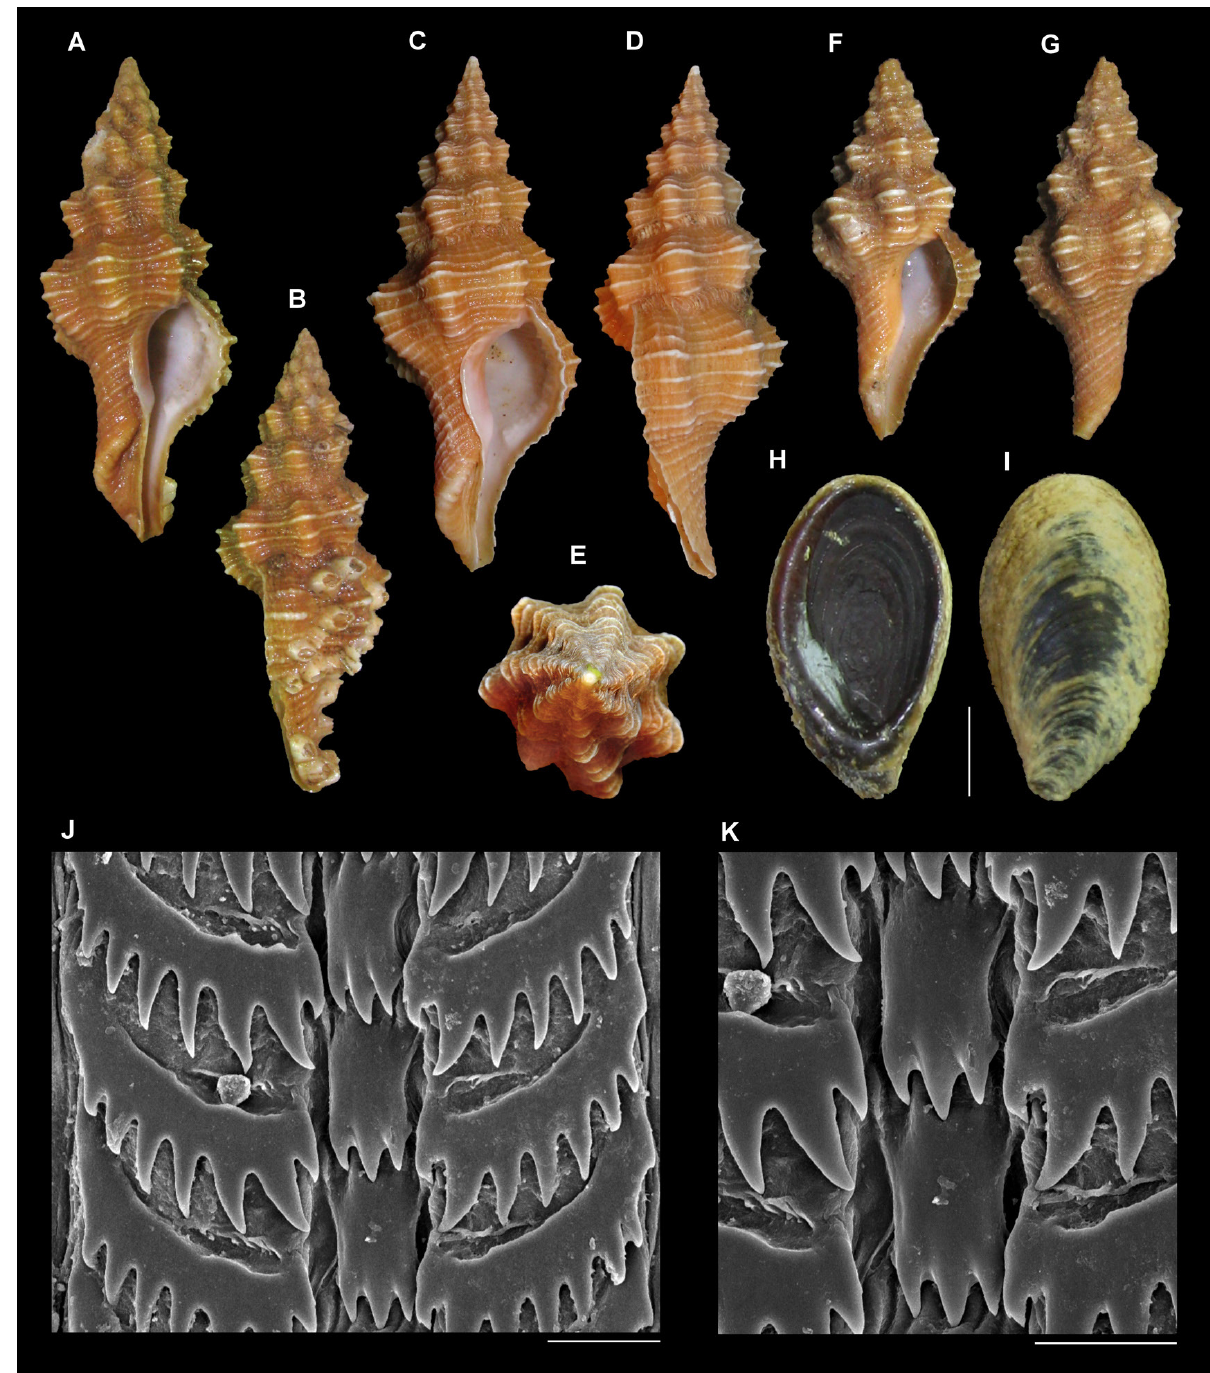
Fig. 6. – Hemipolygona beckyae . A-B, 55.4 mm (MZSP 69764); C-E, 52.4 mm (MZSP 57053); F-G, 38.2 mm (MZSP 69482); H, operculum internal view; I, operculum external view; J, radula; K, detail of rachidian tooth. Scale bars: H-I, 3 mm; J-K, 30